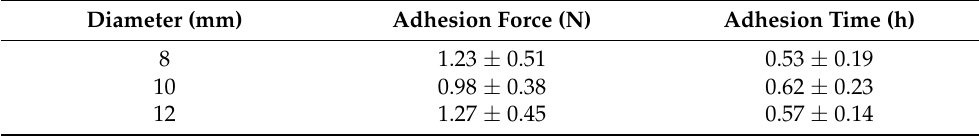
Table 8. Bioadhesive ability of 3D-printed oral films with different diameters (n =